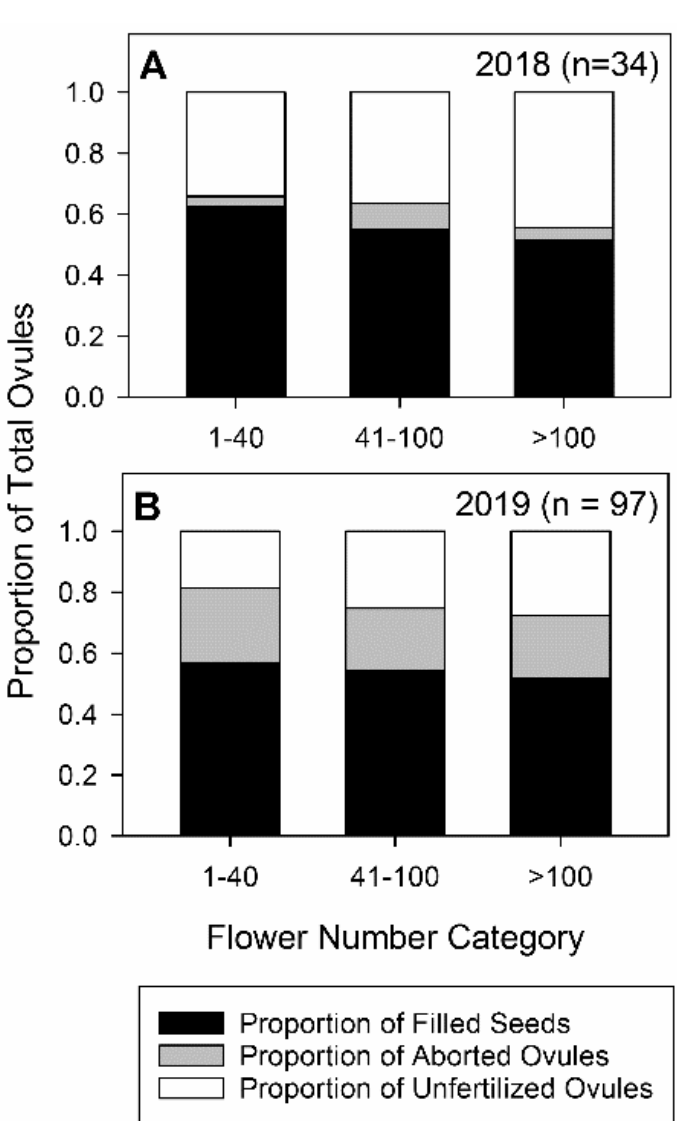
Figure 5. Relationship of ovule fate to mean flower number per plant ( A ) across three populations and for ( B ) Beehive Dome, ( C ) Tonaquint, and ( D ) White Dome in 2019. Note that flower numbers are binned into categories for ease of interpretation but that flower number was not analyzed as binned categories (see Appendix C for full statistical analysis).